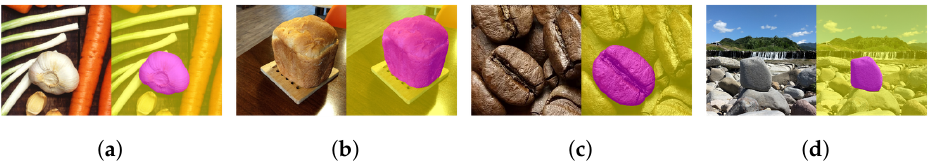
Figure 9. Gained generality and works for various objects. ( a ) A garlic. ( b ) A loaf of bread. ( c ) A roasted coffee bean. ( d ) A stone. The original photo of ( a ) is credited to USDA ARS (Scott Bauer).